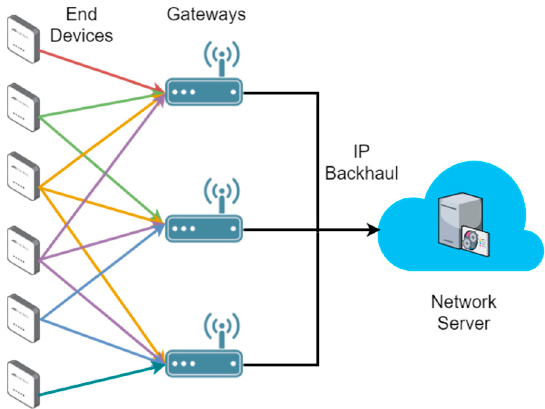
Figure 1. LoRaWAN network architecture. An end device may be associated with more than one gateway. Adapted from [21].